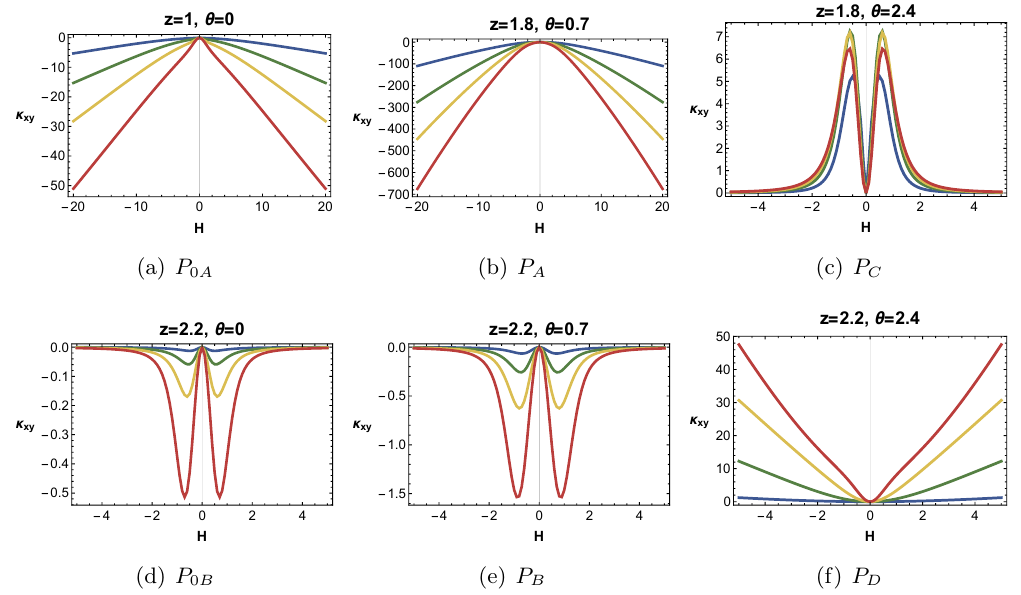
Figure 13 . Temperature evolution for (cid:20) xy ( H ) for di(cid:11)erent ( z; (cid:18) ). Each curves corresponds to T = 0 : 04 ; 0 : 1 ; 0 : 16 ; 0 : 24 for blue, green, yellow, and red respectively. We used q (cid:31) = 0 : 7.